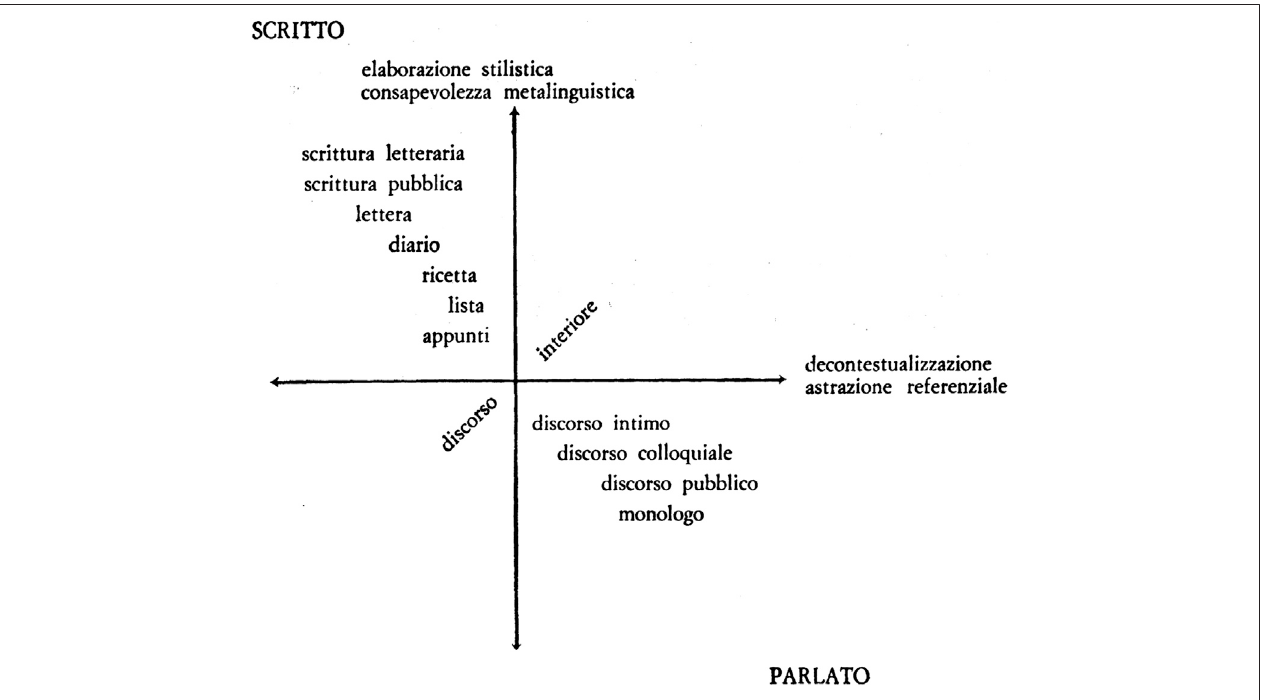
FIGURE 4 | Spoken vs Written Language (and Internal Language) according to Cardona (1986).